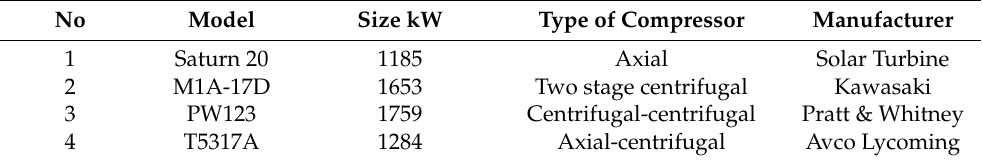
Table 1. The four GT engines with associated compressor